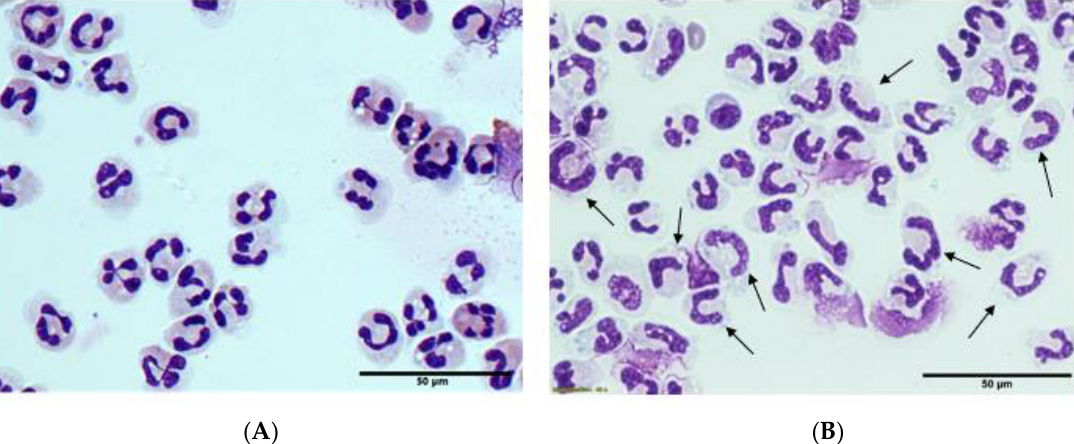
Figure 4. Morphology of neutrophils isolated from ( A ) healthy volunteers and ( B ) septic patients. Arrows indicate examples of immature ‘band cells’ that lack segmented, multi-lobed nuclei. Representative images captured using the 40 × objective (scale bar = 50 µm). Cells were stained with hematoxylin and eosin.